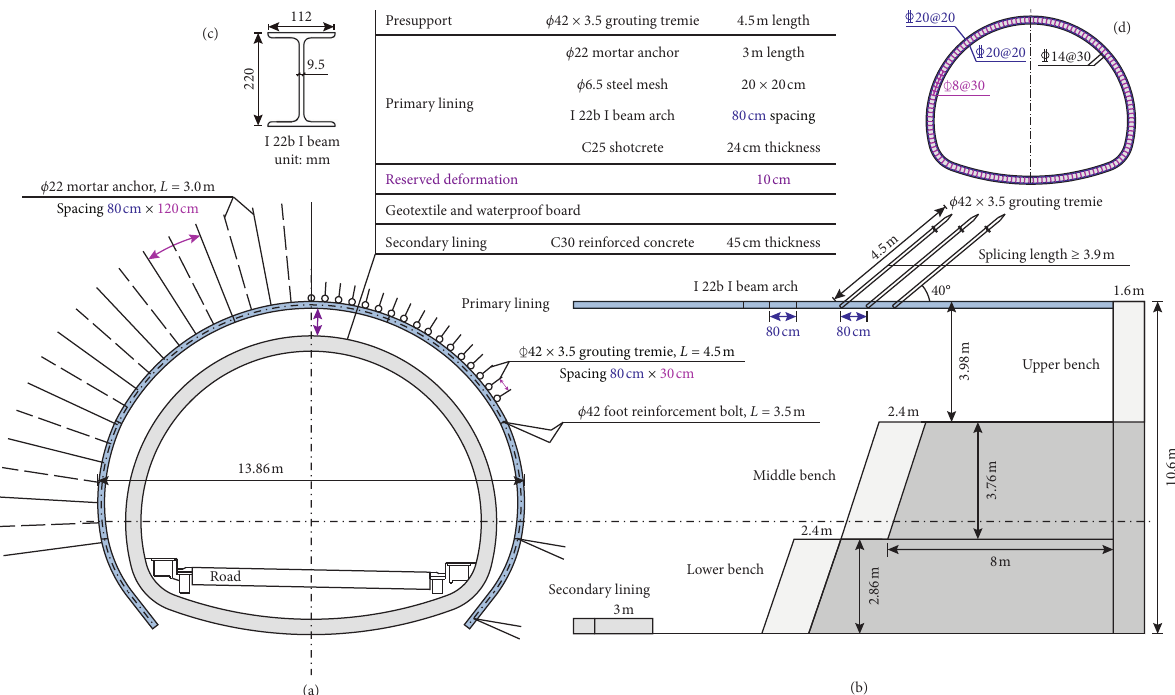
Figure 5: Schematic diagram of construction design for supporting system: (a) cross section; (b) longitudinal section; (c) geometrical information of I 22b I beam; (d) reinforcement design of the secondary lining.